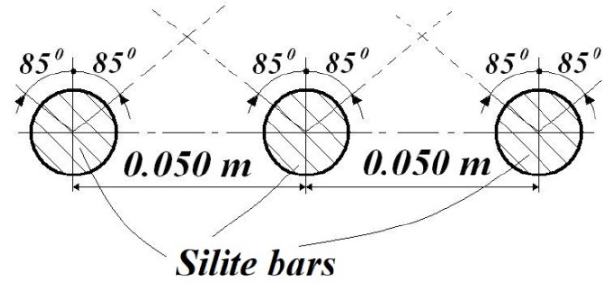
Figure 4. The effective heat transfer offered by the Silite bars [56,64]. One has to mention that the ML was also validated for the case of Equation (5). Based . Q , one has: on the definition of the heat flux